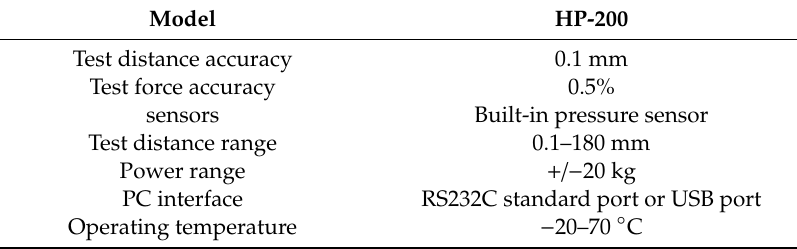
Figure 3. Edberg 0824 push-pull testing machine. Table 1. Parameters of Edberg 0824 push-pull testing